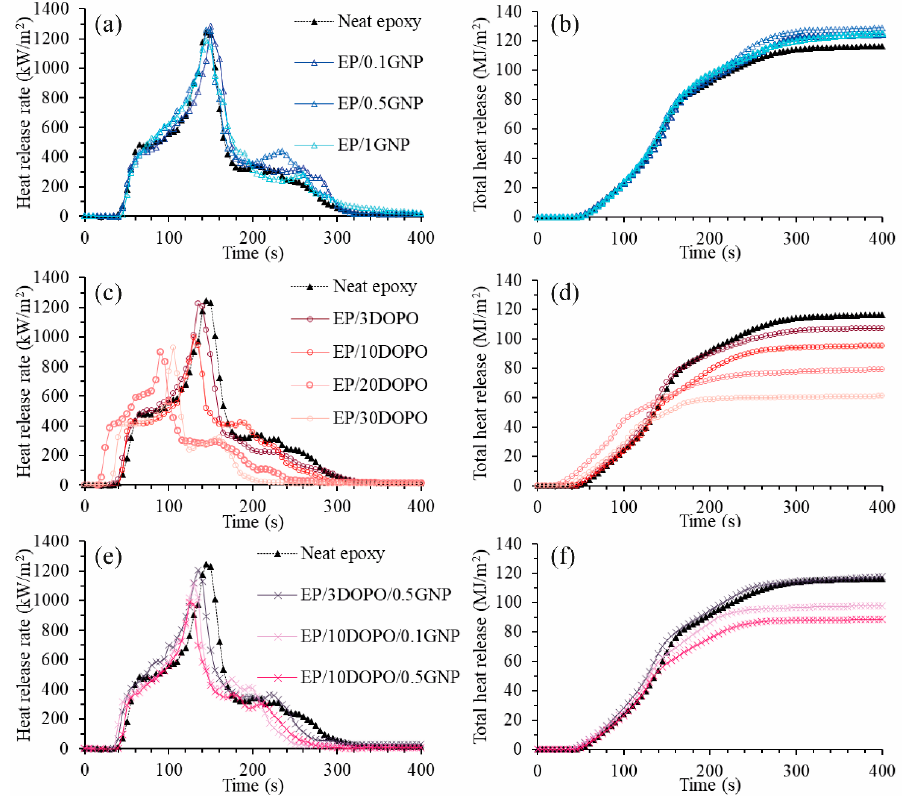
Figure 8. Heat release rate plots from cone calorimetry of neat epoxy resin compared to ( a ) EP/GNP nanocomposites, ( b ) EP/DOPO, and ( c ) EP/DOPO/GNP nanocomposites and total heat release